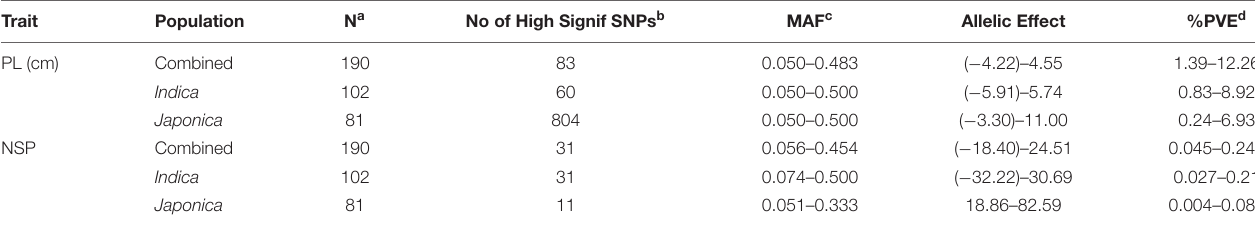
TABLE 2 | Genome-wide highly significant SNPs associated with panicle length (PL-cm) and number of spikelets per panicle (NSP) in in the panel of 190 diverse rice accessions of the USDA rice mini-core collection (URMC) comprising the Combined, Indica , and Japonica populations under high nighttime temperature (HNT) stress.